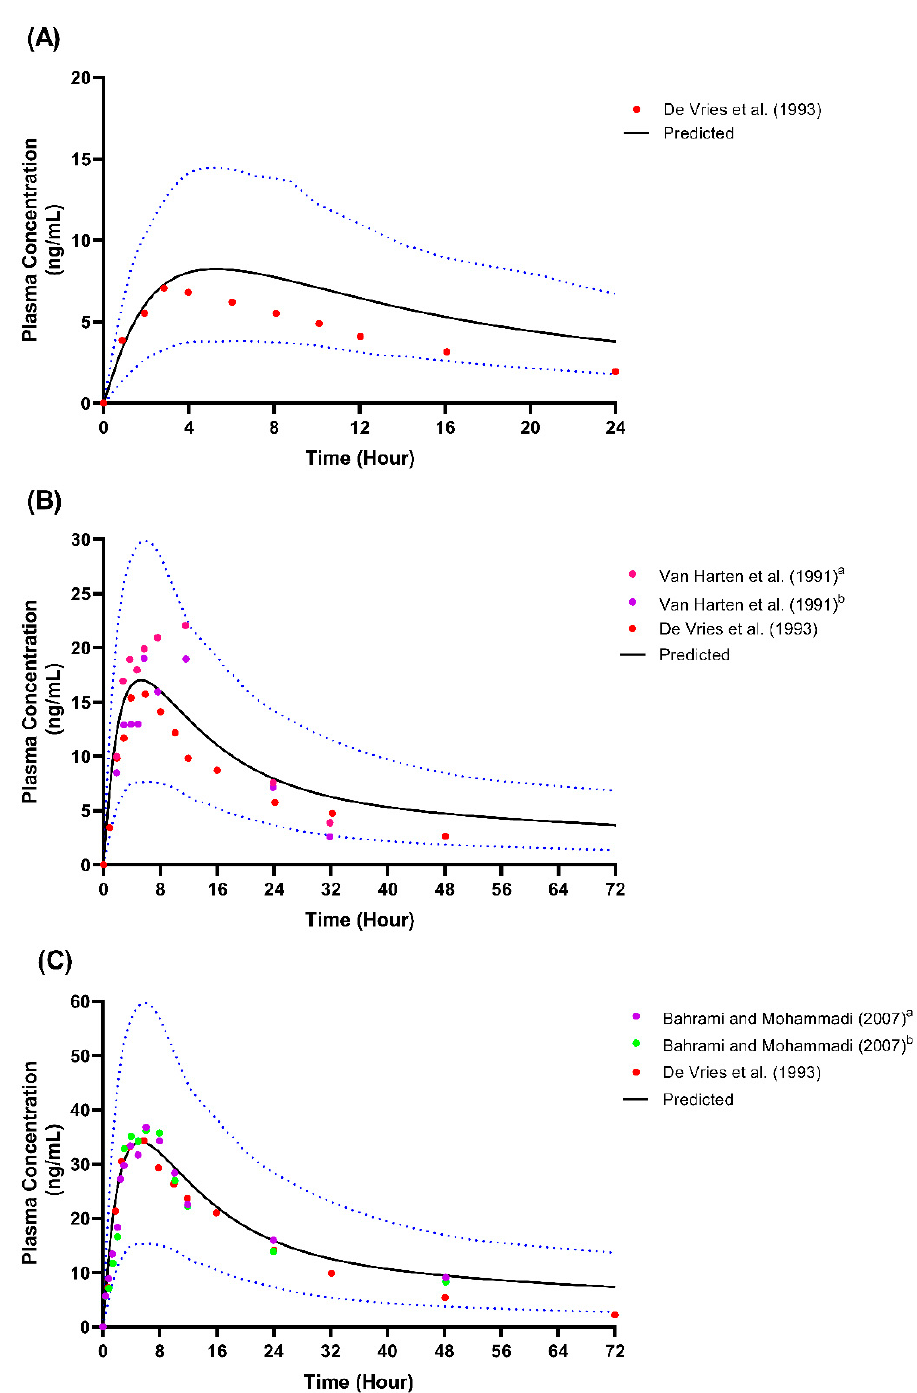
Figure 3. Single-dose studies simulated through model development. ( A ) Single-dose 25 mg; ( B ) Single-dose 50 mg; ( C ) Single-dose 100 mg. Solid lines represent the mean predicted concentration- time profile, with dotted lines representing the 5th and 95th percentile ranges. Solid circles represent observed clinical data from each study. Van Harten et al. (1991) a represents the 50 mg fed study [40]; Van Harten et al. (1991) b represents the 50 mg fast study [40]. Bahrami and Mohammadi (2007) a represents the 100 mg test formulation study [41]; Bahrami and Mohammadi (2007) b represents the 100 mg reference formulation study [41] .